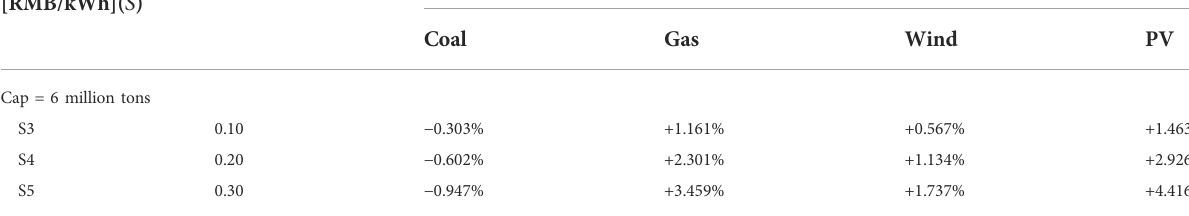
TABLE 3 Electricity